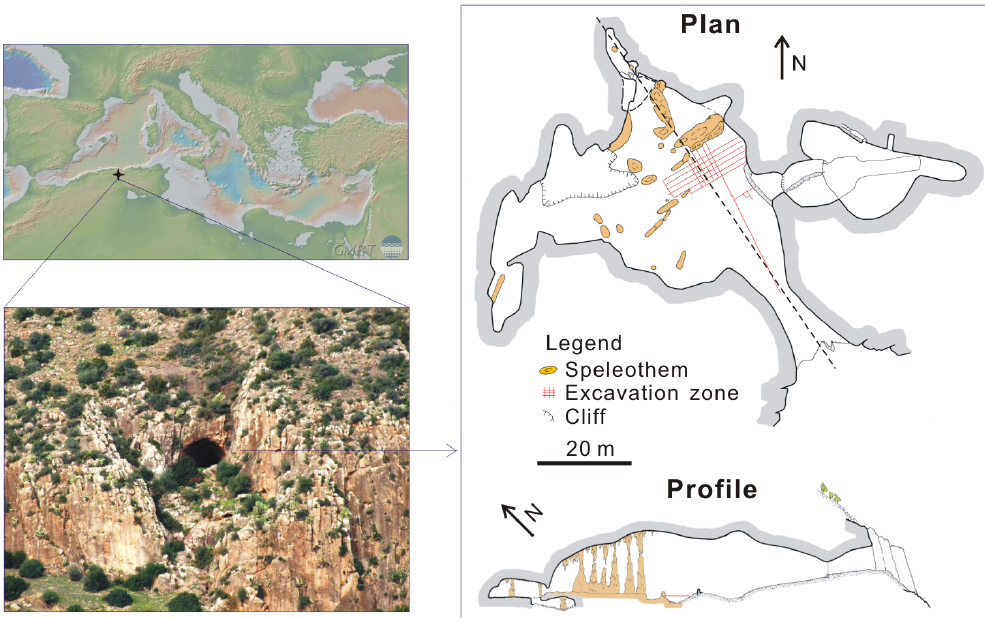
Figure 1. The Gueldaman GLD1 Cave (36 ◦ 26 (cid:48) N, 4 ◦ 34 (cid:48) E, 507ma.s.l.). The top left shows the location of the Gueldaman GLD1 Cave, in the Northern-Algerian part of the Western-Mediterranean basin; the bottom left shows a photo of cave entrance and local vegetation cover; the right panel shows maps of inner cave where stalagmites and archaeological deposits are